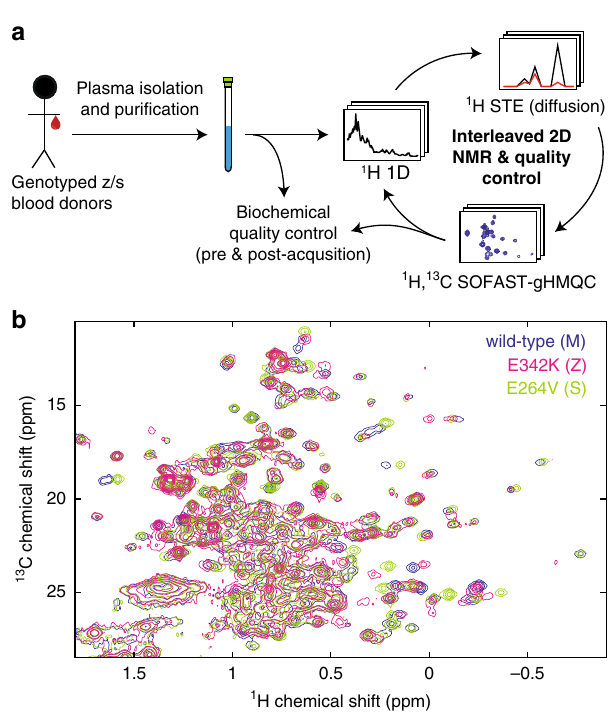
Fig. 2 Ex vivo NMR spectroscopy of AAT. a Overview of ex vivo AAT sample preparation, data acquisition and quality control strategy for ex vivo NMR. b 1 H, 13 C SOFAST-gHMQC spectra (Supplementary Fig. 5) acquired for ex vivo wild-type (M), Z and S AAT variants (298 K, 900 MHz). Contour levels are normalised for concentration and acquisition